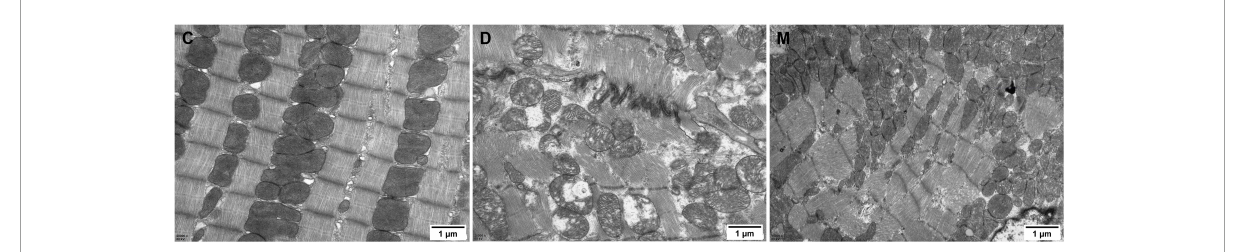
FIGURE2 Electron micrographs of myocardium in groups C, D, M. The myocardium of rats from group C maintained continuous regular sarcomeres and constituted myofibrils, with mitochondria distributed between myofibrils that were structurally intact. The myofibrils of the myocardium in rats from group D were fragmented and disorganized, and the mitochondria were arranged in a disorganized manner with broken cristae, and with inner membranes that were swollen and appeared vacuolated or ruptured. The arrangement of myocardial sarcomeres in rats from the M group were regular, with intact mitochondrial structure with limited swelling and